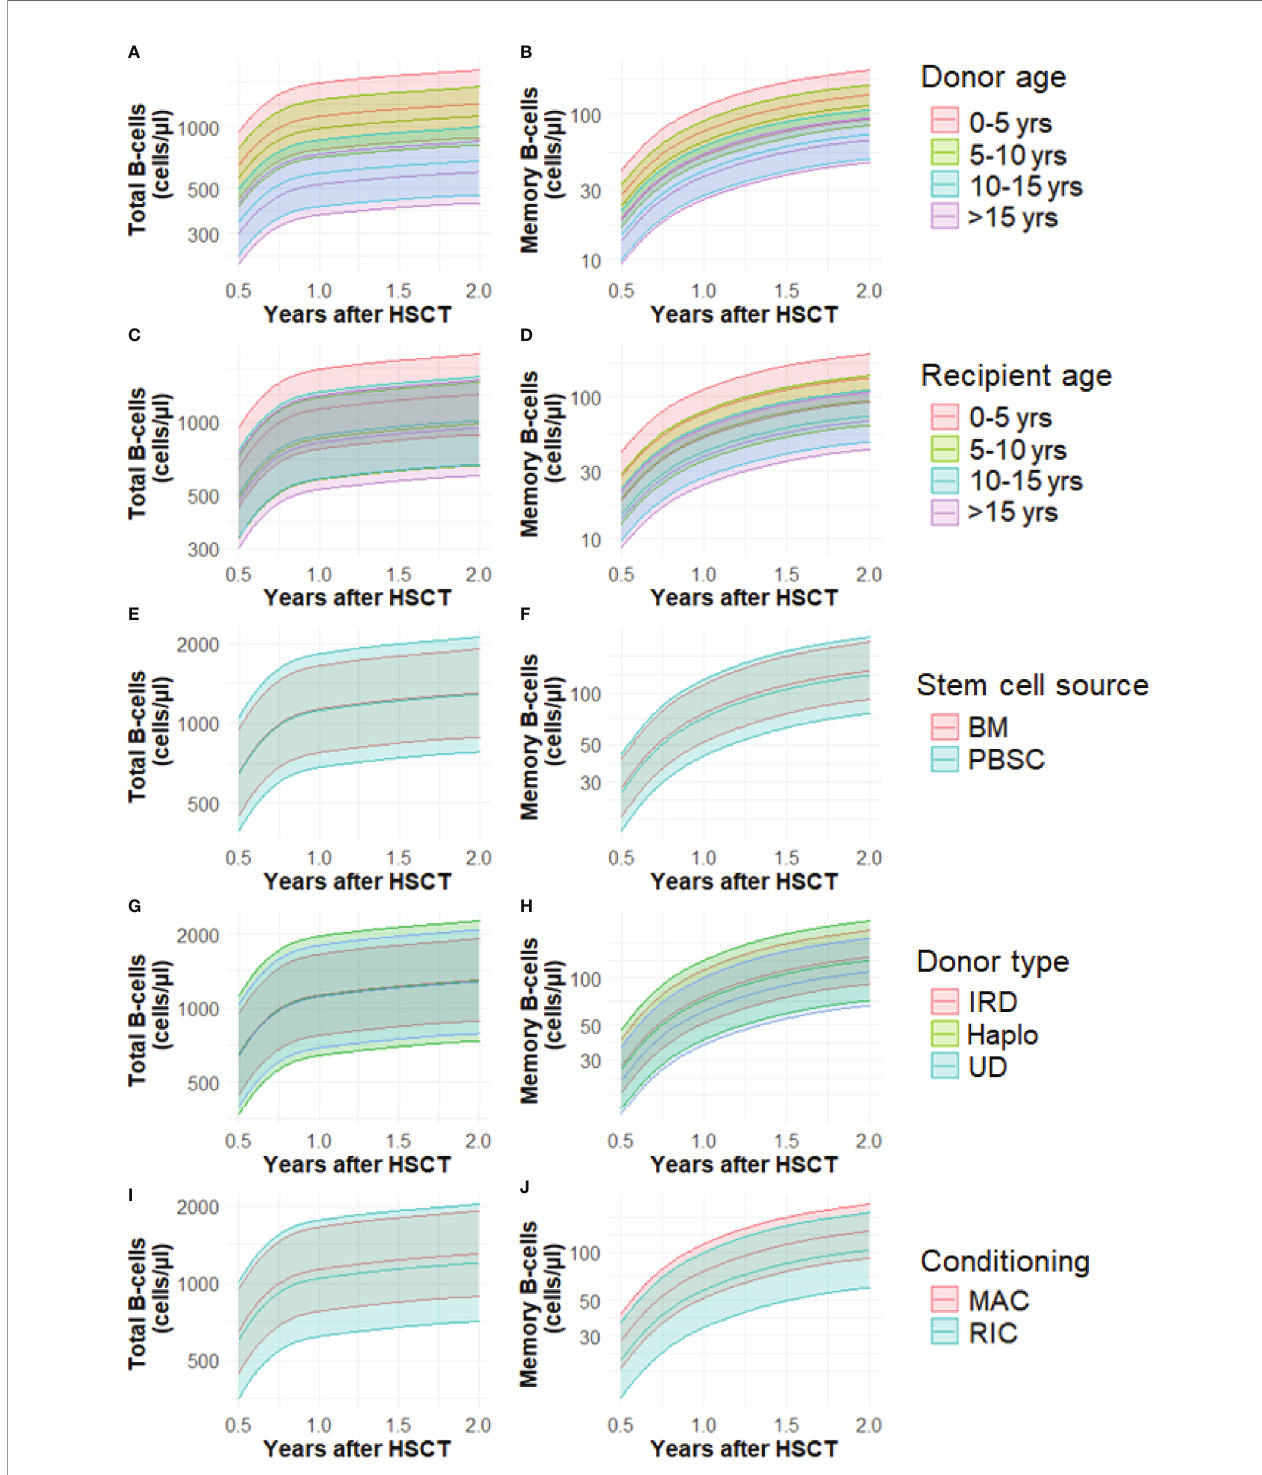
FIGURE 3 | (A – J) Cell number trajectories of total B-cells and memory B-cells and the effect of baseline factors over time. Yrs, years; BM, bone marrow; CB, cord blood; PBSC, peripheral blood stem cells; Haplo, haplo-identical; IRD, identical related donor; UD, unrelated donor; MAC, myeloablative; RIC, reduced intensity conditioning. Lines represent mean predicted values, shaded areas the 95% CI ’